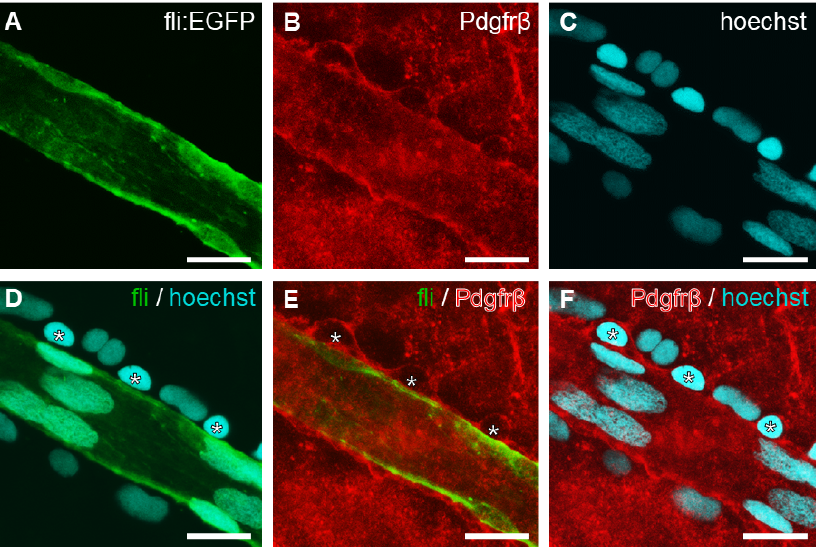
Figure 4. Identification of pericytes in retinal vessel structures. Confocal fluorescence image of vessel stained with anti-Pdgfr β ( B , E , F ; red) and Hoechst 33342 ( C , D , F ; blue). Merged image of ( A , C , D ), ( A , B , E ), or ( B , C , F ), respectively. Vascular smooth muscle cells are Pdgfr β -positive and surrounding vascular endothelial cells. Pdgfr β -positive pericytes (asterisks) are also distinguishable from vascular endothelial cells ( D – F ). Scale bar, 20 μ m.